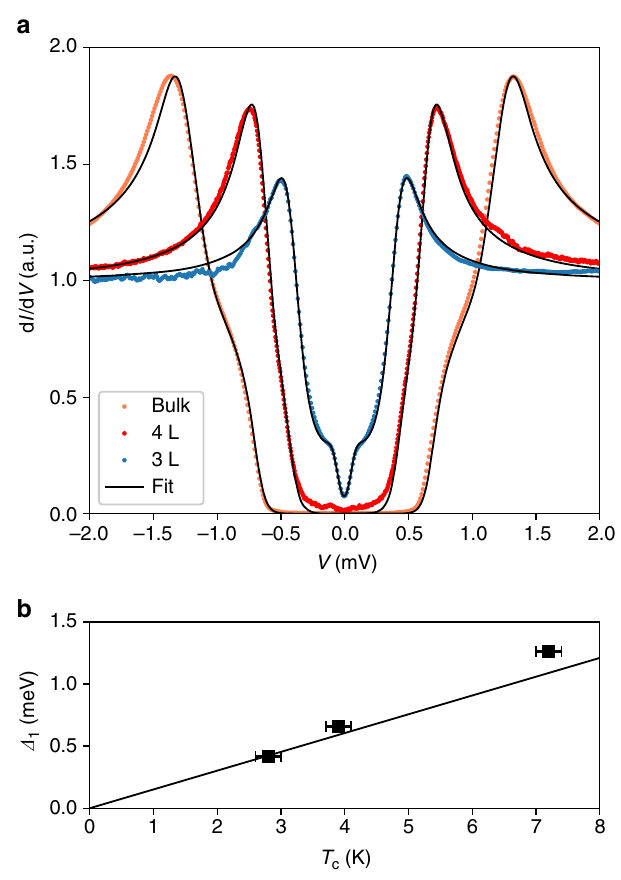
Fig. 2 Thickness dependent tunneling spectrum. a Normalized differential conductance of vdW tunnel junctions with NbSe 2 of varying thickness: 20 nm thick (bulk, orange), 4 layers (red) and 3 layers (blue). Each curve is fi t to the SSM model ( fi t parameters reported in Supplementary Note 3). b Δ 0 of the devices in a , extracted from the SSM model, as a function of T c . Solid line shows a comparison to the BCS prediction: Δ = 1.76 K B T c . T c is de fi ned by a 5% reduction of the zero bias conductance relative to the normal conductance of the junctions. The error bars result from the